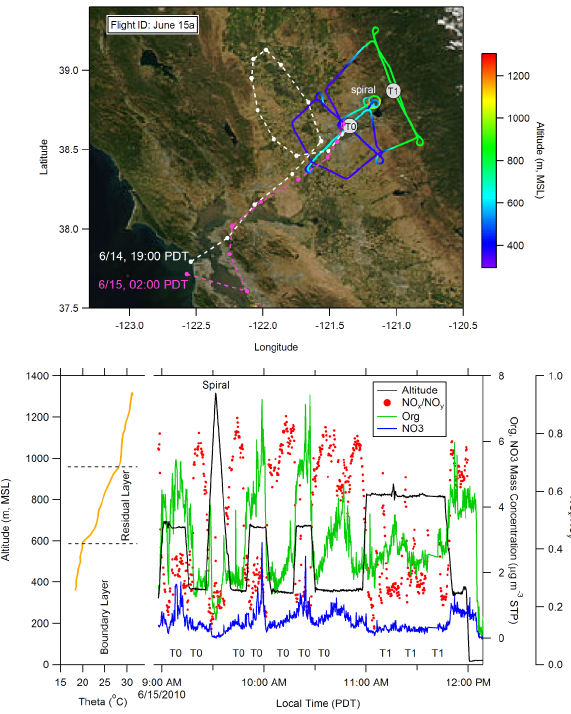
Fig. 8. Example of evidence for aged aerosols (enriched in organic and nitrate) that were often found to be present in the residual layer in the morning. Top: G-1 flight tracks on the morning of 15 June, color coded by flight altitude. The dotted white and pink lines rep- resent forward trajectories of air parcels (see text). Bottom right: vertical profile of potential temperature at the location of the spiral. Bottom left: flight altitude, org and NO 3 mass concentrations, and NO x /NO y ratio plotted along the flight track as a function of local